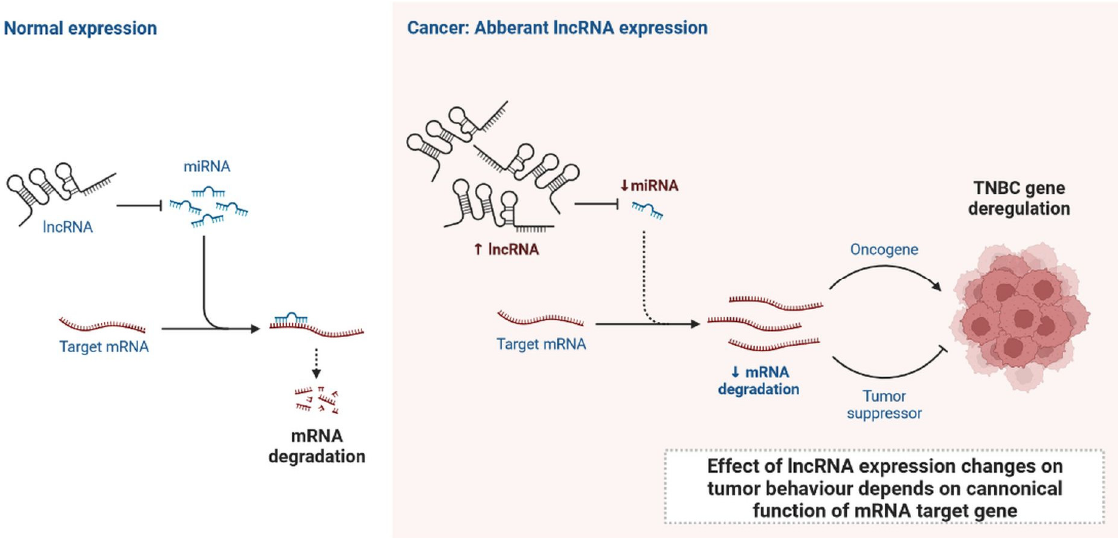
Figure 4. Normal expression of lncRNA and effect of lncRNA expression changes on tumour behaviour depends on canonical function of mRNA target gene.